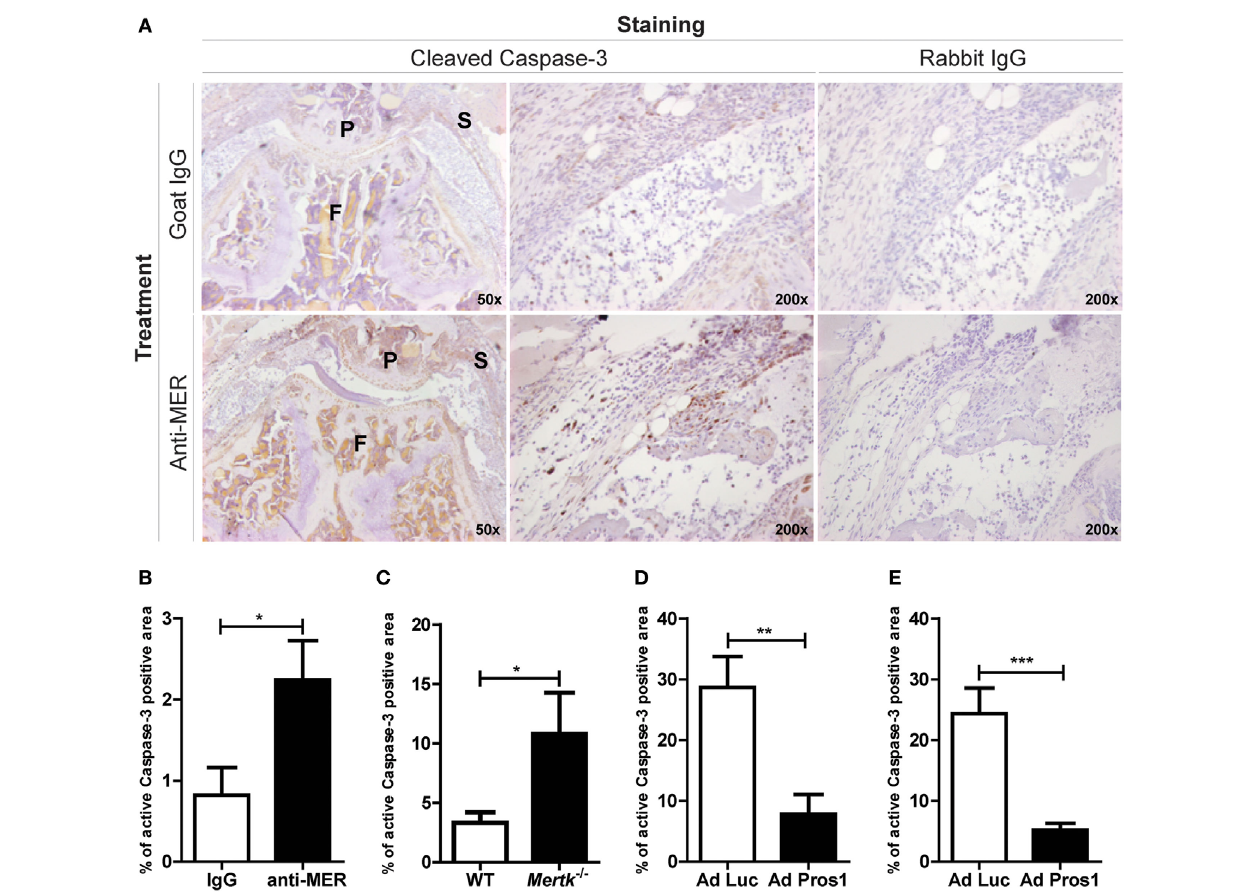
FigUre 5 | Evaluating the outcome on efferocytosis after treatment with MER-specific antibodies, Mertk gene ablation or Pros1 overexpression. (a) Immunohistochemical staining for cleaved Caspase-3 in knee joints of collagen-induced arthritis (CIA) mice injected with IgG or anti-MER. Shown are representative pictures of knee joint sections with similar microscopic scores of inflammation, in two different magnifications. (b) Pictures of knee joint sections shown in (a) were quantified and the cleaved Caspase-3 positive area was corrected by the total inflamed area ( n = 10–12 knee joints). (c) Quantification of immunohistochemical staining for cleaved Caspase-3 in knee joints of wild-type (WT) or Mertk − / − mice with KRN serum transfer arthritis (STA) mice ( n = 10–18 knee joints). (D) Quantification of immunohistochemical staining for cleaved Caspase-3 in knee joints of CIA mice intravenously injected with Ad Luc or Ad Pros1 ( n = 18 knee joints). (e) Quantification of immunohistochemical staining for cleaved Caspase-3 in knee joints of KRN STA mice intra-articularly injected with Ad Luc or Ad Pros1 ( n = 12 knee joints). P, patella; F, femur; S, synovium. For (b–e) , data are presented as mean + SEM. * p < 0.05, ** p < 0.01, *** p < 0.001 with unpaired t -test. See also Figure S5 in Supplementary